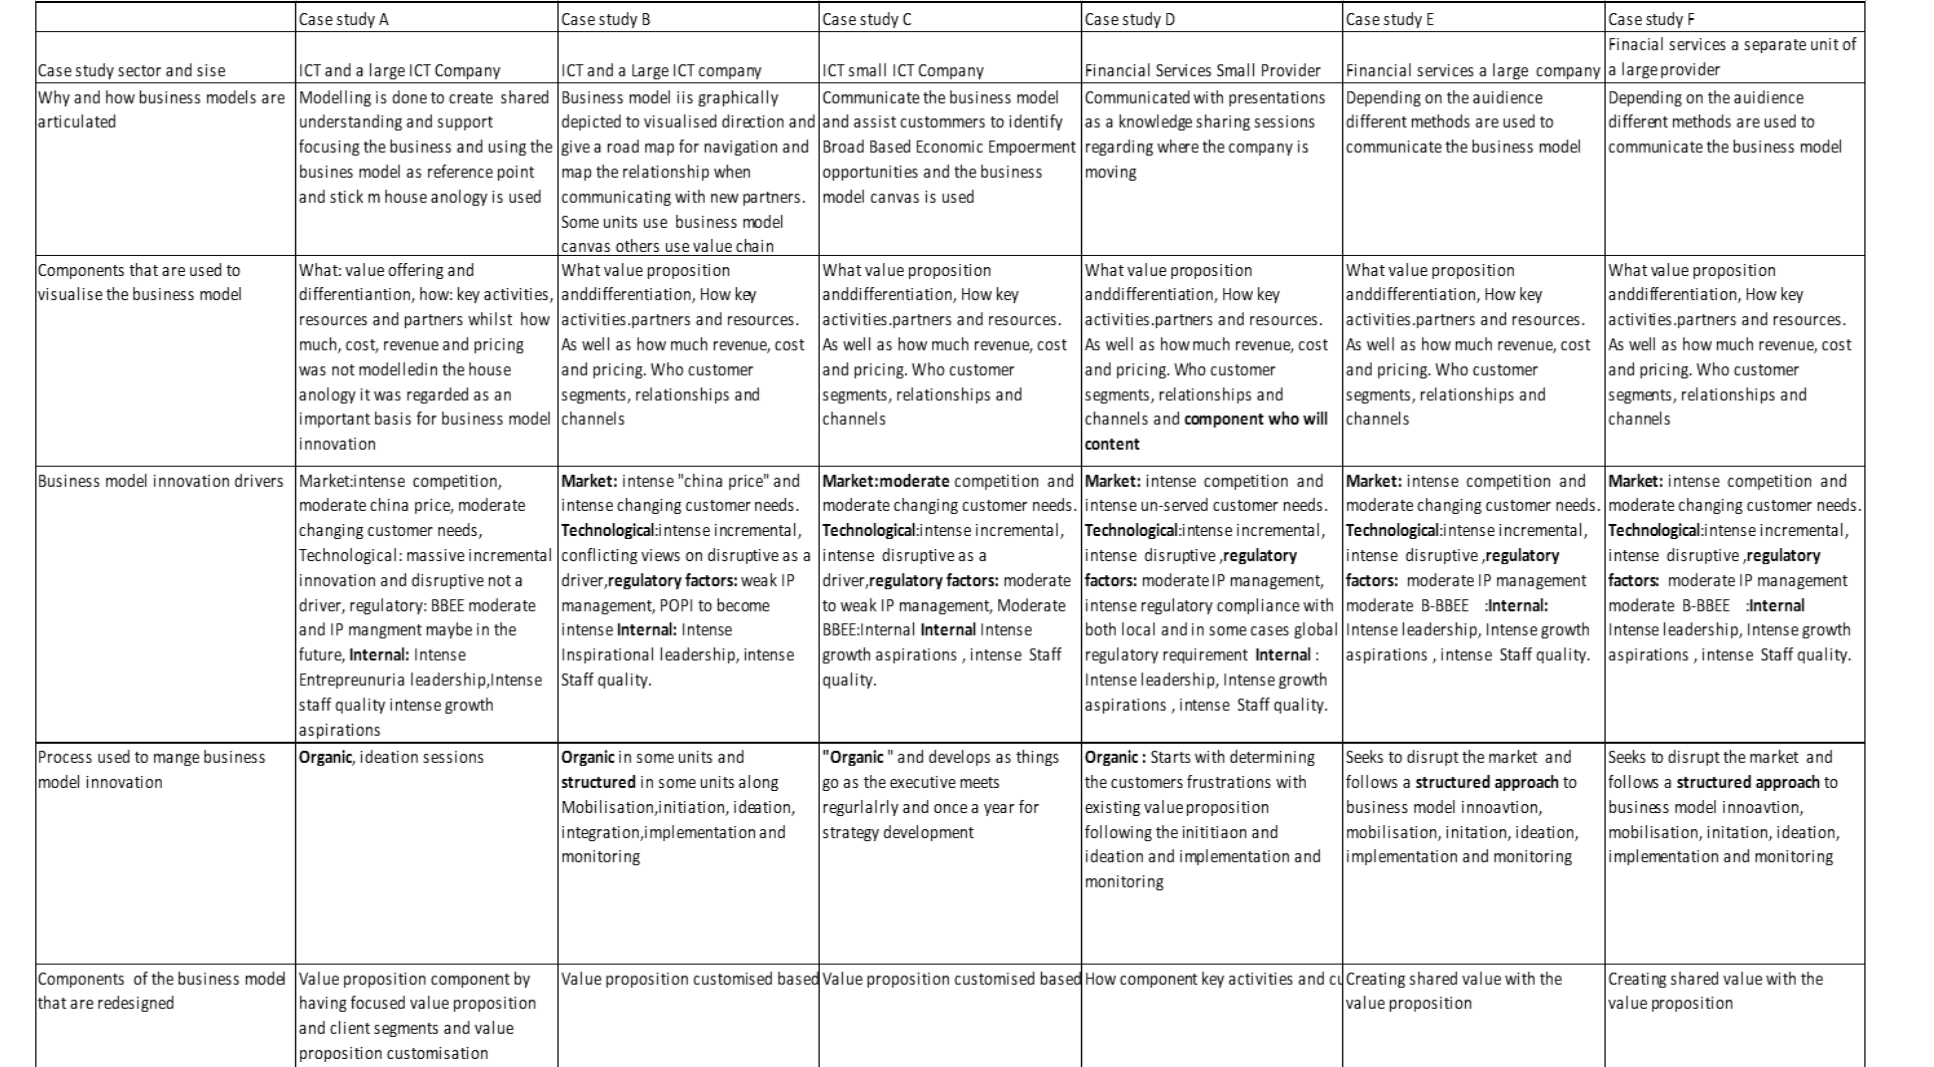
Table 1. Case study